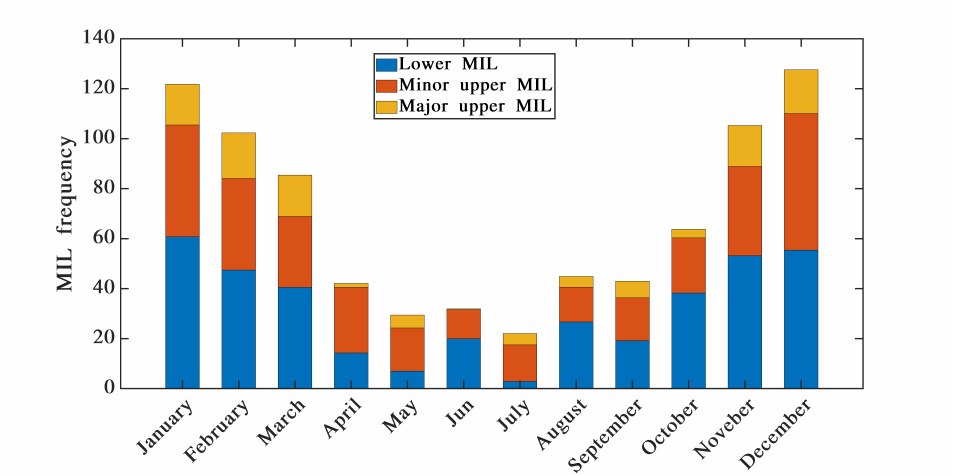
Figure 7. Histogram of the MIL frequency (the percentage of times the MILs occurred) for each cluster from 1978 to